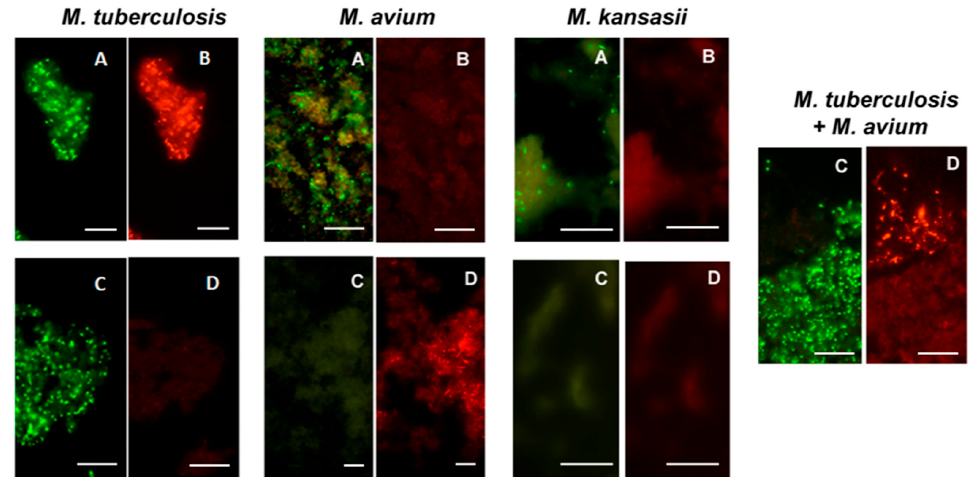
Figure 7. Dual color fluorescence reactivity of Mycobacterium tuberculosis, Mycobacterium avium and Mycobacterium kansasii in the MN Genus-MTBC FISH and MTBC-MAC FISH tests. Paired photographs showing dual colour fluorescence in the same microscopic field with A -MN Genus- specific probe (green fluorescence) and B -MTBC-specific probe (orange fluorescence) in the MN Genus-MTBC FISH test; and C -MTBC- specific probe (green fluorescence) and D -MAC-specific probe (orange fluorescence) in the MTBC-MAC FISH test. Mycobacteria used in the FISH tests were reference cultures of M. tuberculosis , M. avium , and M. kansasii , as well as an artificially mixed culture of M. tuberculosis and M. avium . Scale bars represent approximately 50 µ m. Reproduced with permission under the creative commons license from Reference [28].